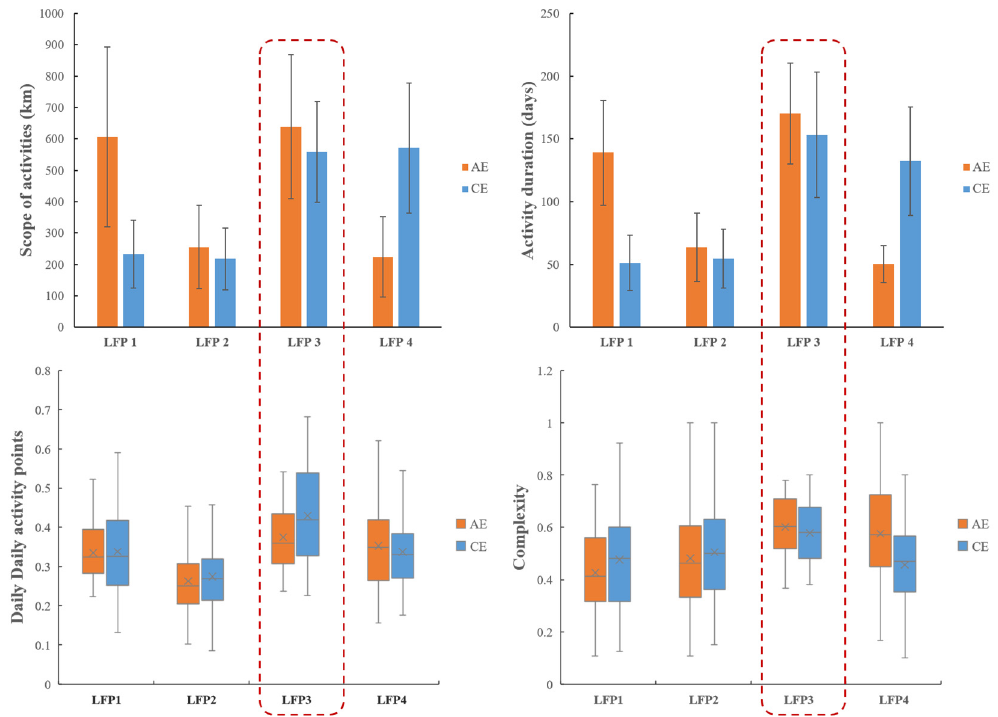
Figure 7. Statistical characteristics of the AE and CE LFPs.